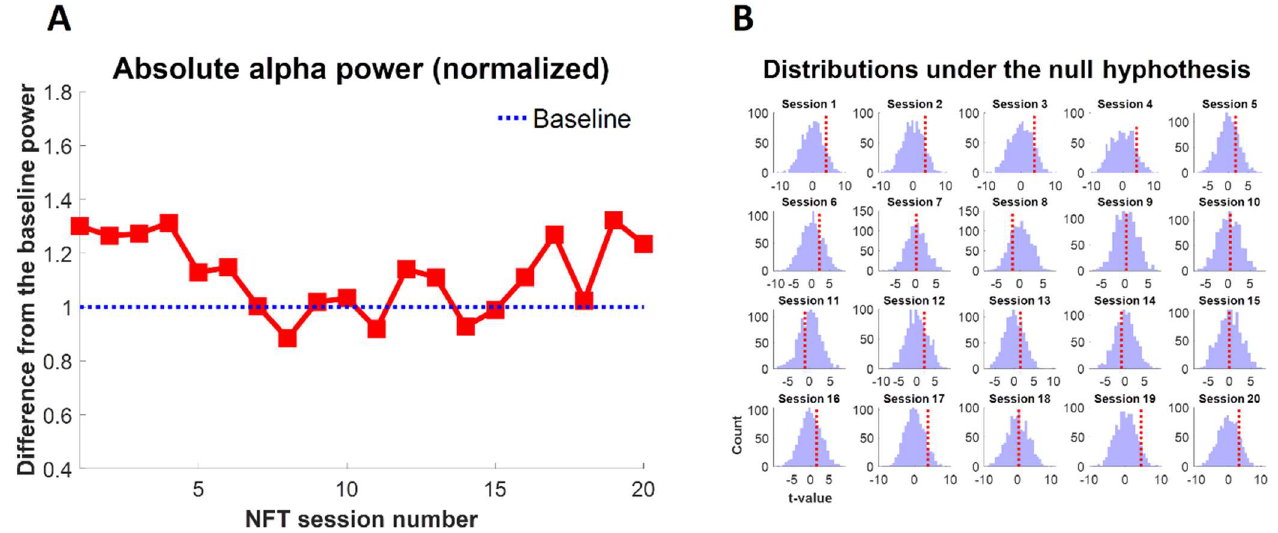
Figure 5. ( A ) The difference in alpha power after each NFT session from the baseline and ( B ) the distribution of each session under the null hypothesis (using permutation testing). The dotted red vertical line represents the observed statistic.